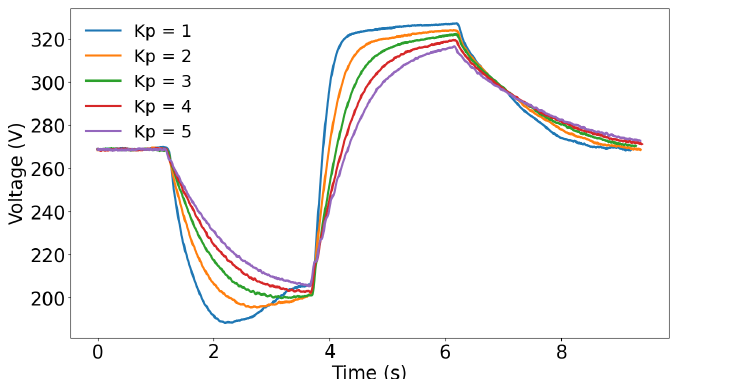
Figure 16. System voltage disturbance with a triangular feedforward signal, different K p and T i = 0.2.